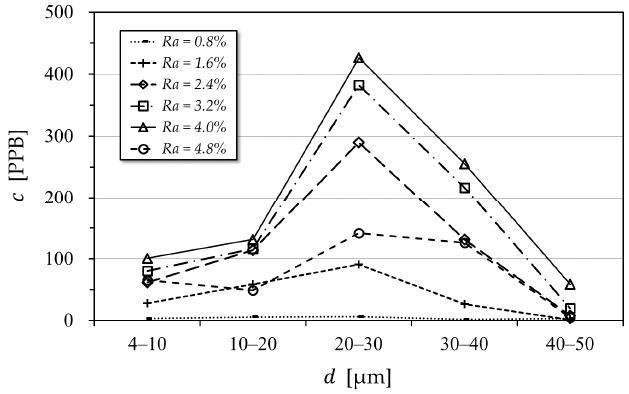
Figure 8. Bubble concentration with respect to the airflow ratios at the pump pressure of 5 bar.